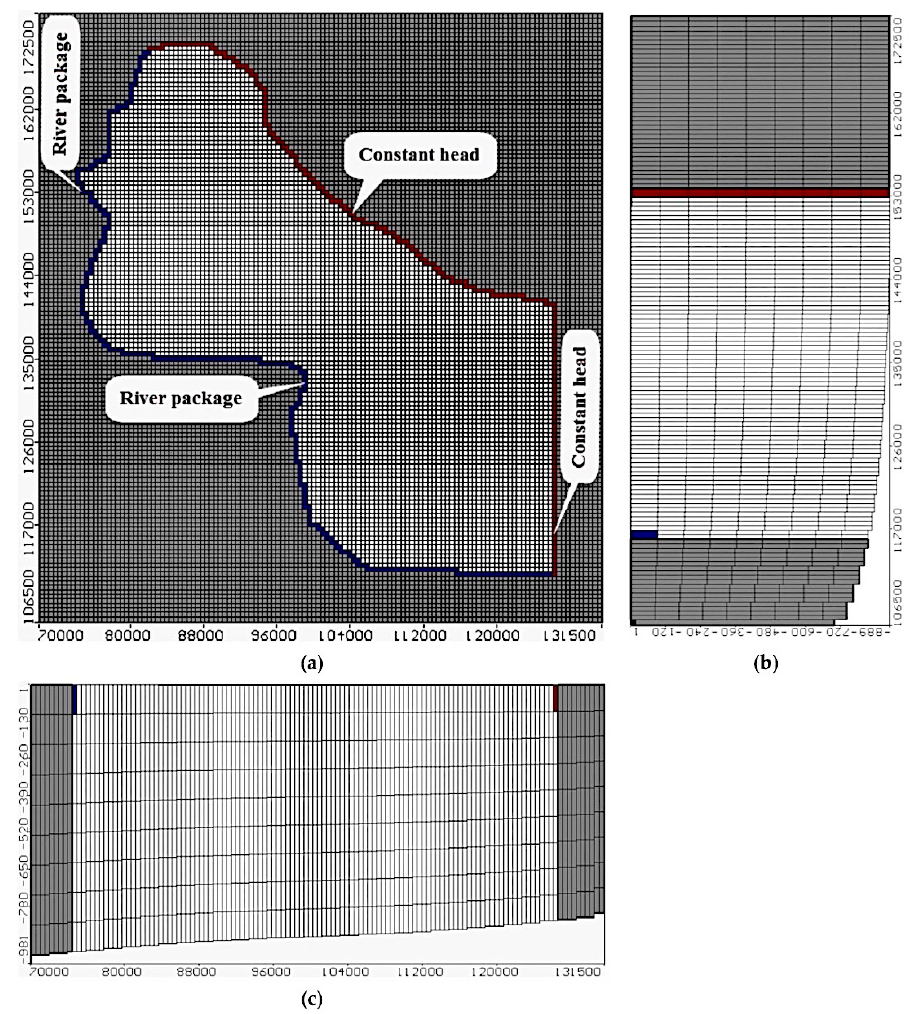
Figure 2. Model boundary conditions and cross section in ( a ) plan, ( b ) longitudinal section in X-direction and ( c ) transversal section in Y-direction .